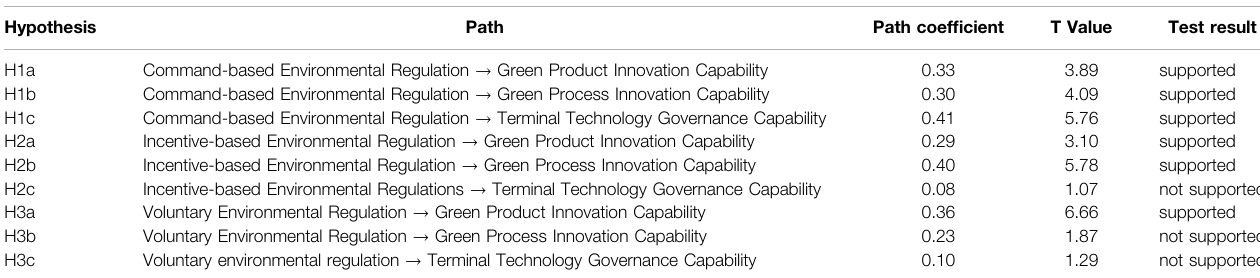
TABLE 5 | Test results.